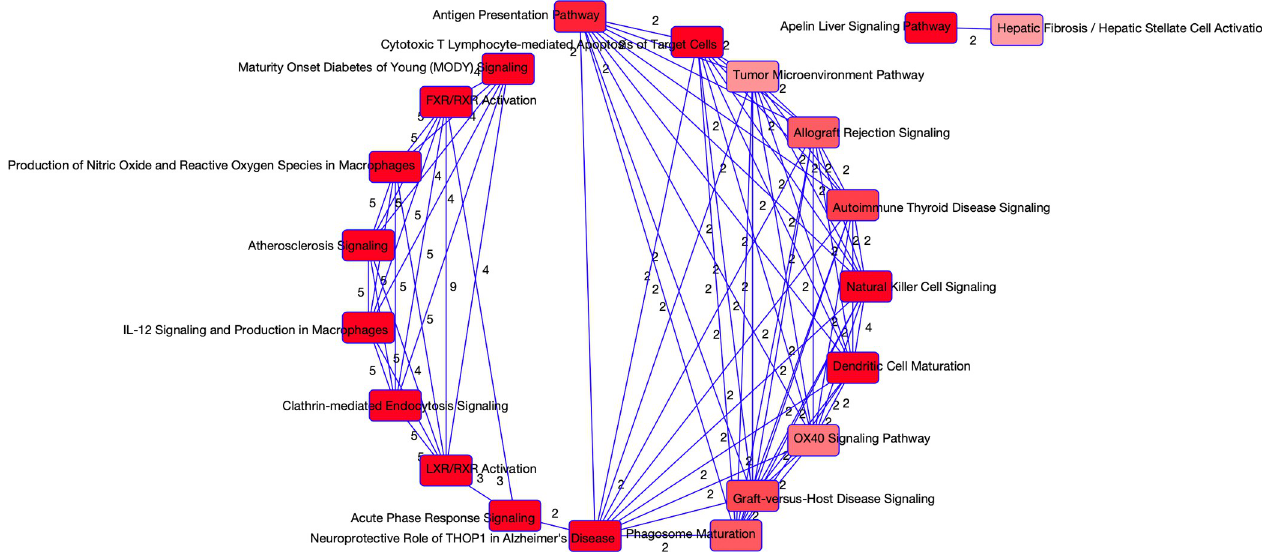
Fig 7. Overlapping networks associated with COVID-19 visual of the overlapping networks enriched in COVID-19 as determined from the proteomics data. The nodes represent the networks and the edges represent the overlapping proteins between the networks. The edge labels give the number of overlapping molecules between the